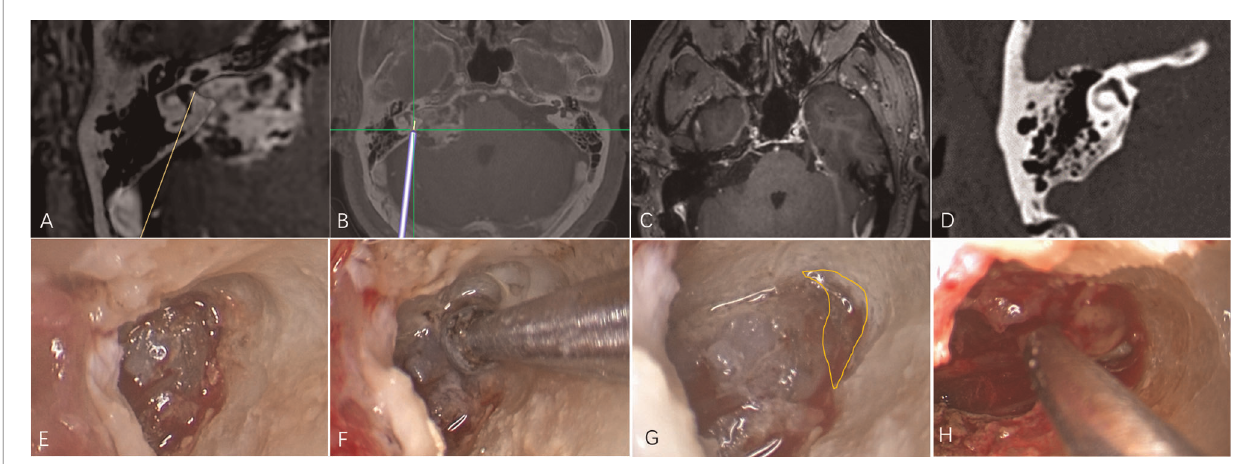
FIGURE 2 | An illustrative case. ( A ) The tumor was classi fi ed as of medial type on the basis of fusion images. ( B ) Intraoperative navigation. ( C ) Postoperative MR showing that the tumor within the IAC has been completely resected. ( D ) Postoperative CT showing maximal removal of the posterior wall of the canal. ( E ) Endoscopic image after drilling under microscope guidance. ( F ) Endoscopic drilling of the deep bone; ( G ) The area within the yellow line shows the extent of endoscopic drilling. ( H ) Endoscopic resection of residual tumor at the fundus of the